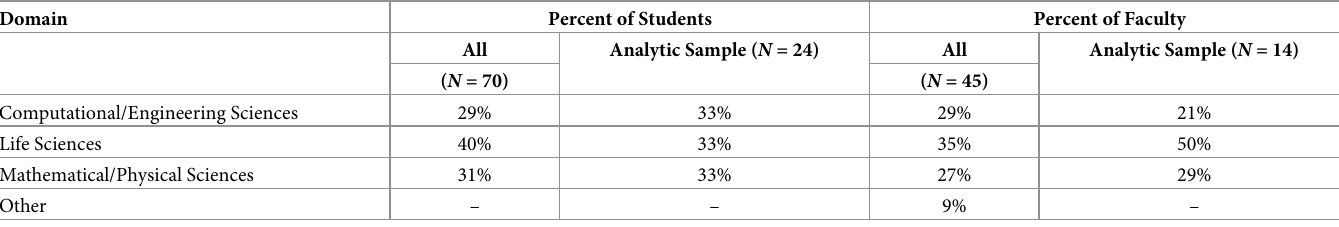
Table 5. COMBINE student and faculty disciplines.